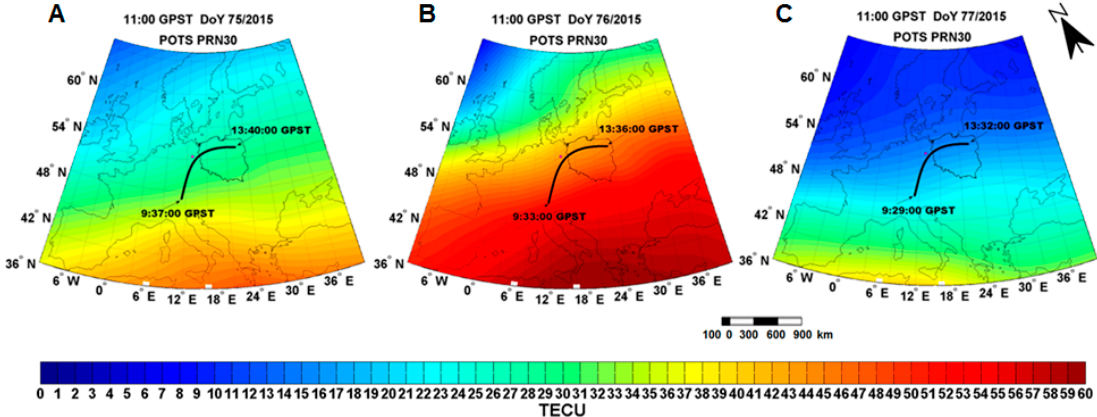
Figure 5. Example TEC maps derived from the UWM-rt1 model on a quiet day before the storm ( A ), the stormy day ( B ) and one day after the storm ( C ) all at 11:00 GPST. Dark lines represent tracks of the GPS PRN30 satellite observed by POTS station.